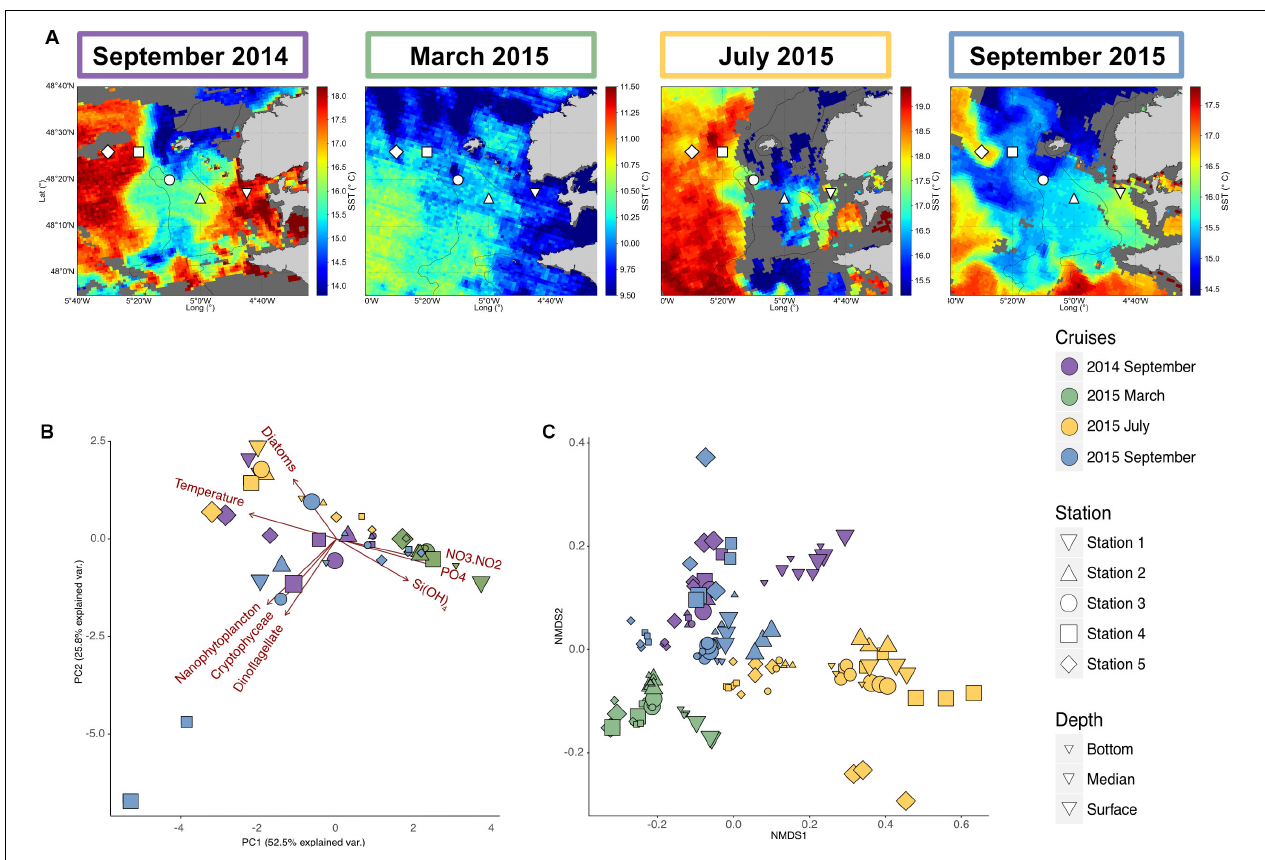
FIGURE 1 | Environmental and bacterial communities characteristics of the Iroise Sea for the different cruises. (A) Map of the Satellite Sea Surface Temperatures (SST) in the Iroise Sea for each cruise (September 2014 the 8th, March 2015 the 6th, July 2015 the 2nd and September 2015 the 8th), highlighting in the summer cruises the presence of the Ushant front that separates offshore warm stratified waters and coastal cooler mixed waters. The shape corresponds to the different stations sampled, with at each time 2 or 3 depths. Surface waters are highly dynamic and some eddies are conspicuous during September 2015, bringing cold water into surface stratified waters. Thus SST map are not enough to define the frontal area and vertical profiles are needed to characterize the different water masses ( Supplementary Data Sheet S1 ). (B) Principal Component Analysis of the environmental characteristics for the different samples ( n = 49) based on temperature, inorganic nutrients [Si(OH) 4 , NO3 + NO2, PO4] concentrations and microscopic count of the different phytoplanktonic groups ( Diatom , Nanophytoplankton , Cryptohyceae , and Dinoflagellate ). (C) NMDS of the bacterial diversity based on Bray-Curtis dissimilarities among the different cruises, stations and depth (stress = 0.091). For bacterial diversity, biological triplicates were done for each station and depth, explaining the higher number of samples ( n =